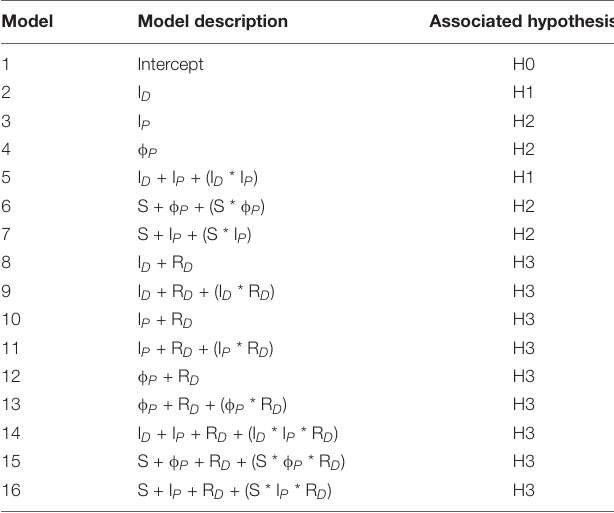
TABLE 2 | List of models to analyze community invariability as response